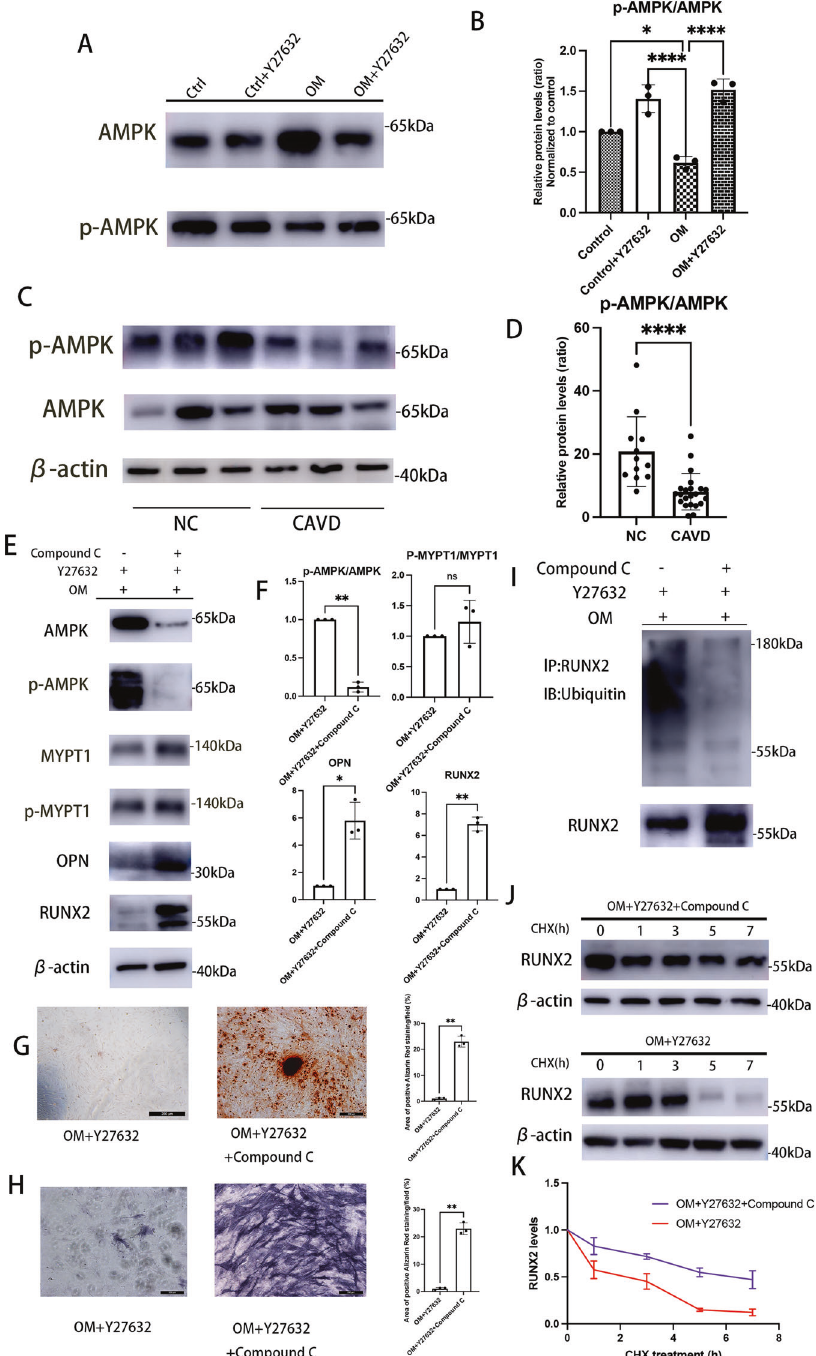
Fig. 4 AMPK inhibition abolished Y-27632-enhanced RUNX2 proteasome degradation. A Western blot and quanti fi cation ( B ) for AMPK and p-AMPK in human VICs in osteogenic medium (OM) or complete medium (CM) treated with or without Y27632 (one-way ANOVA followed by Bonferroni post hoc test). C Western blotting for AMPK and p-AMPK of representative human aortic valves, either calci fi ed or non-calci fi ed. β -actin was used as loading control. D Quanti fi cation of AMPK and p-AMPK of human calci fi ed ( n = 22) and non-calci fi ed aortic valves ( n = 12) (Mann – Whitney test). E Western blotting for AMPK, p-AMPK, MYPT1, p-MYPT1, OPN and RUNX2 of OM-Y27632-cultured human VICs treated with or without Compound C. β -actin was used as loading control. F Quanti fi cations of data presented in E (Unpaired two-tailed Student ’ s t -test). G , H Representative images and quanti fi cations of alizarin red and ALP staining for OM-Y27632-cultured human VICs treated with or without Compound C. (unpaired two-tailed Student ’ s t -test). Scale bar = 200 µm. I Ubiquitination of immune-precipitated RUNX2 in OM-Y27632-cultured VICs treated in the presence or absence of Compound C. J Lysates of OM-Y27632-treated human VICs with or without Compound C treated with 50 ug/ml cycloheximide (CHX) for the indicated times were examined by western blot and ( K ) RUNX2 levels were quanti fi ed (one-way ANOVA followed by Bonferroni post hoc test). Data are shown as mean ± SD. * P < 0.05, ** P < 0.01, *** P < 0.001, **** P < 0.0001.